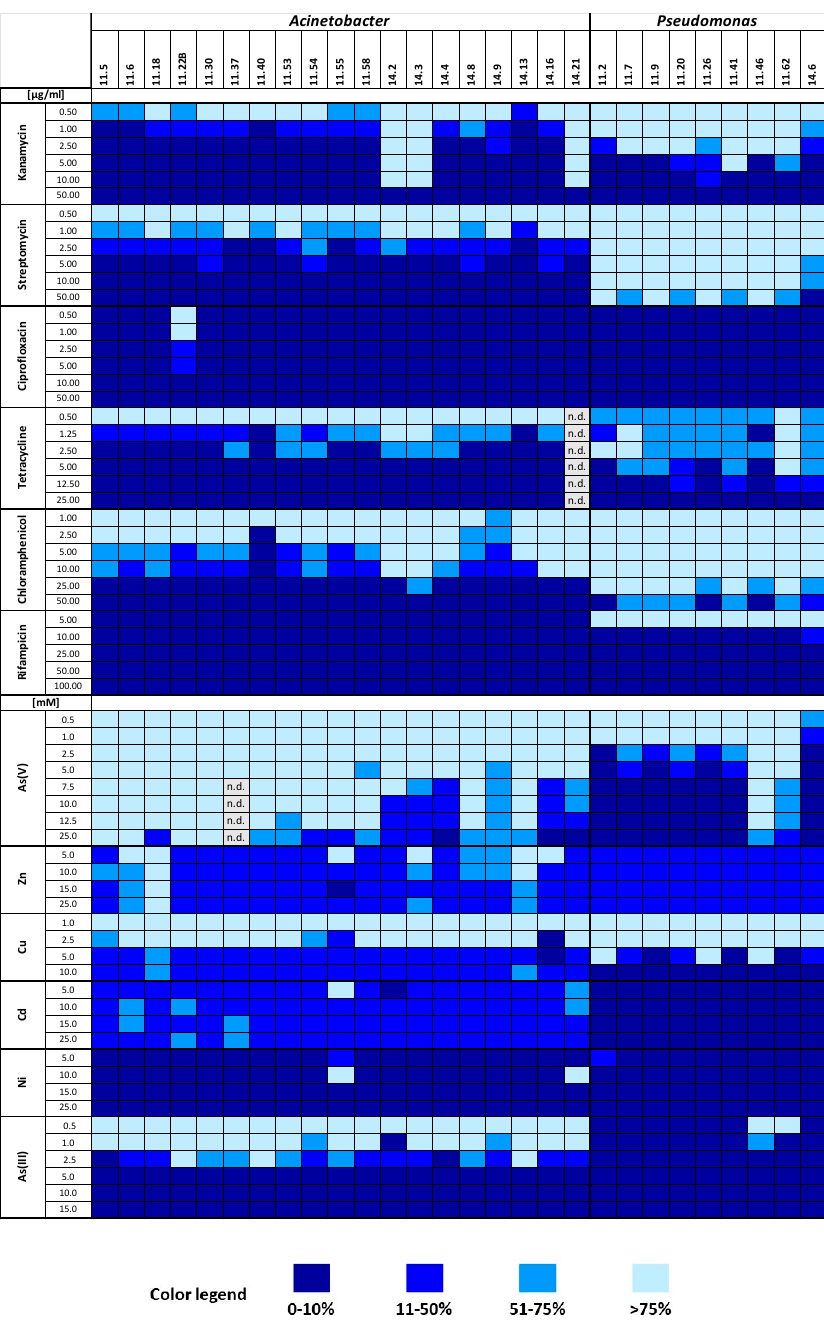
Figure 7. Resistance patterns towards antibiotics and heavy metals of the Acinetobacter and Pseudomonas strains isolated from the Infernaccio waterfalls. Colors: navy 0–10% growth; blue 11–50% growth; deep sky blue 51–75% growth; light blue > 75% growth. Abbreviations: n.d., not determined.